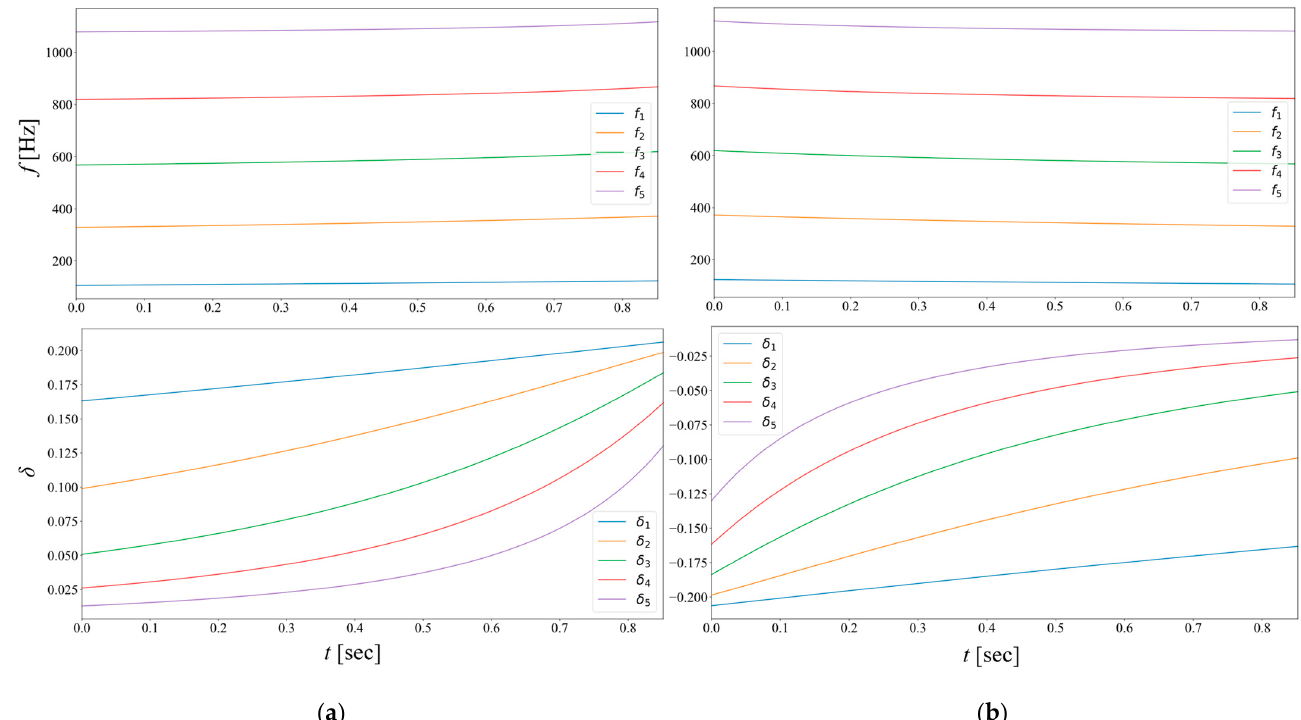
Figure 5. Pylon-mass system eigenfrequency f i , δ i , i = 1,2,3,4,5 evolution with time for the case of ( a ) decreasing fluid mass ( µ > 0 ) and ( b ) increasing fluid mass ( µ < 0 )